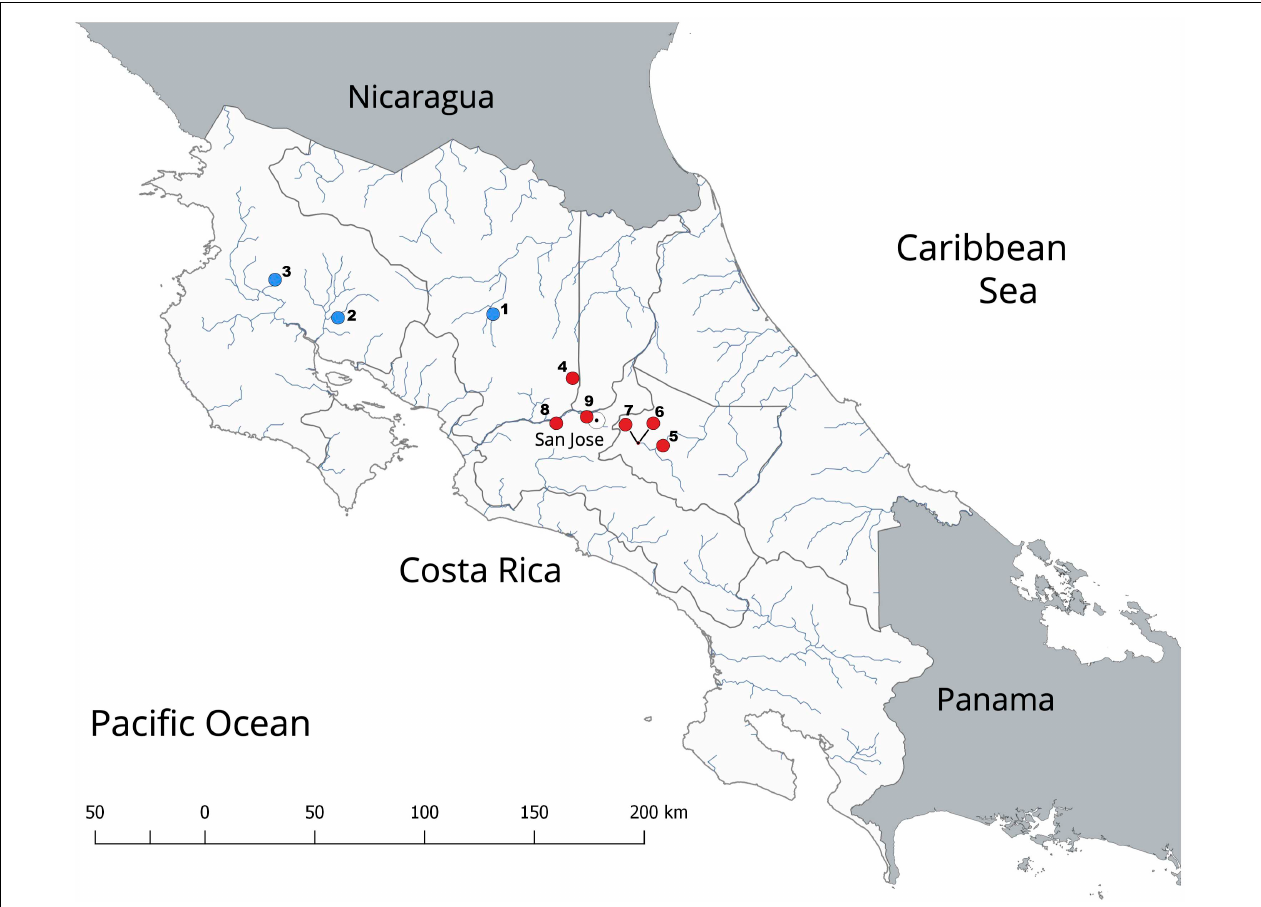
FIGURE 1 | Map showing the locations of the reported invasive alien crayfishes in Costa Rica. Red circles indicate Procambarus clarkii populations; blue circles indicate Cherax quadricarinatus populations. Numbers (1–9) indicate the following locations: (1) Río Balsa, Ciudad Quesada, Alajuela Province; (2) Universidad Técnica Nacional, Bagaces, Guanacaste Province; (3) Irrigation Channels in Bagatzi, Guanacaste Province; (4) Fraijanes Lagoon, Alajuela Province; (5) Hydroelectric Dam Cachí, Cartago Province; (6) Jardín Botánico Lankester Lagoons, Cartago Province; (7) Instituto Tecnológico Costarricense Lagoons, Cartago Province; (8) Peace Park, El Rodeo, San José Province; (9) La Sabana Lake, San José